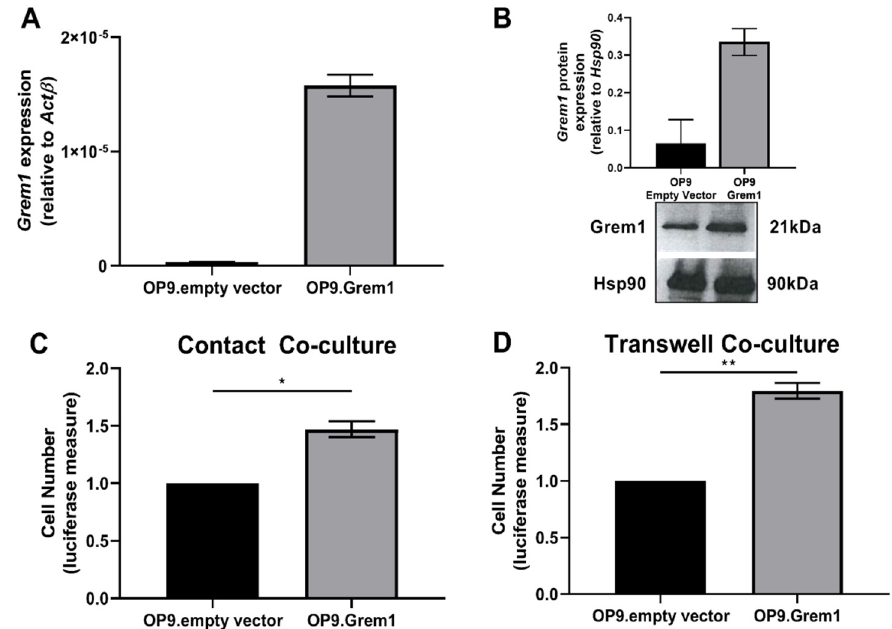
Figure 3. Elevating BM stromal cell expression of Grem1 promotes an increase in 5TGM1 MM PC proliferation. Grem1 was overexpressed in the murine BM stromal cell line, OP9. Grem1 transgene expression in OP9 stromal cells was confirmed by ( A ) RT-PCR and ( B ) representative Western blot (graph depicting densitometric analysis of two independent Western blots). Proliferation of 5TGM1 MM PCs in ( C ) cell-cell contact and ( D ) Transwell co-cultures with OP9 empty vector and Grem1-overexpressing OP9 (OP9.Grem1) stromal cells was measured by luciferase activity after 72 h of culture. Graphs depict mean ± SEM of three replicate experiments normalized to the OP9 empty vector control, * p < 0.05, ** p < 0.01, t -test.